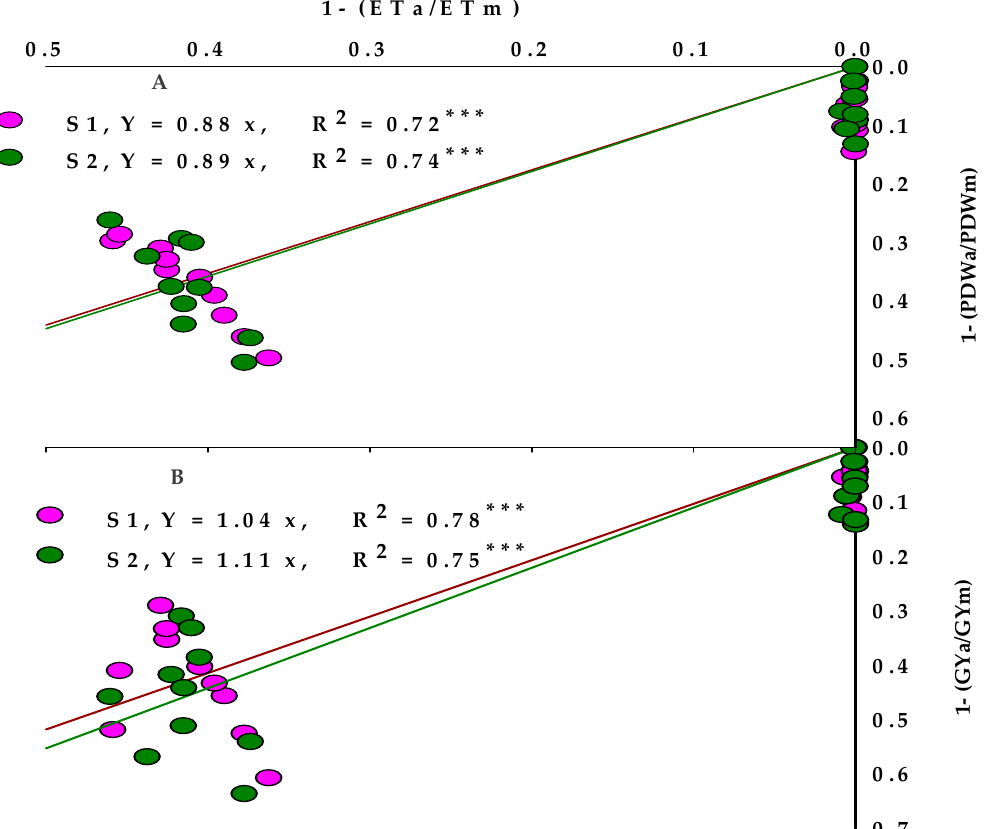
Figure 7. Yield response factor (ky) for pooled data of tillage, irrigation, and mulching treatments shown as the relationship between the relative decrease in plant dry weight (PDW) ( A ) or grain yield GY ( B ) and the corresponding relative decrease in evapotranspiration (ET) for 2019 − 2020 (S1) and 2020 − 2021 (S2) growing seasons. *** indicate significant at p < 0.001. Table 4. Yield response factor (ky) shown as the relationship between the relative decrease in plant dry weight (Ky PDW ) and grain yield (Ky GY ) and the corresponding relative decrease in evapotranspi- ration for different mulching treatments under conventional tillage (CT) and reduced tillage (RT) practices in the 0.50 ET treatment in two growing seasons.